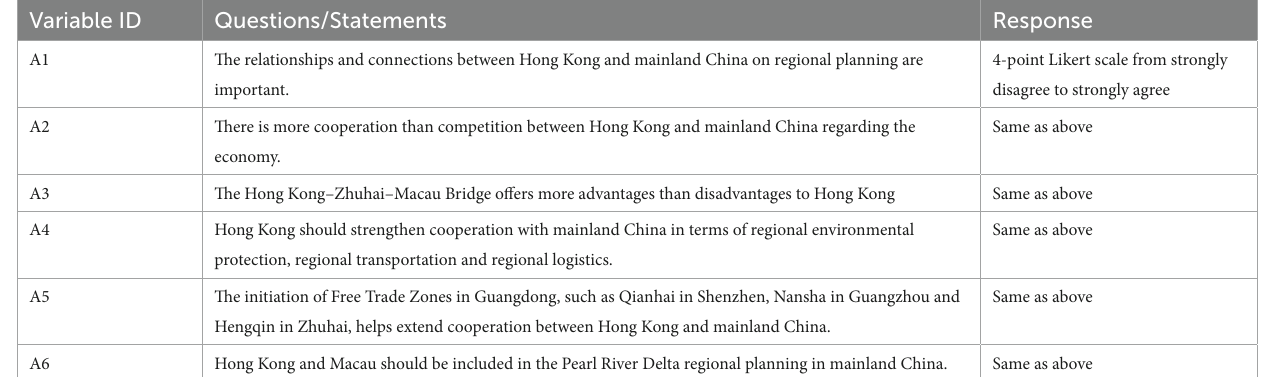
TABLE 1 Question items for measuring the students’ views on regional cooperation between Hong Kong and mainland China. Variable